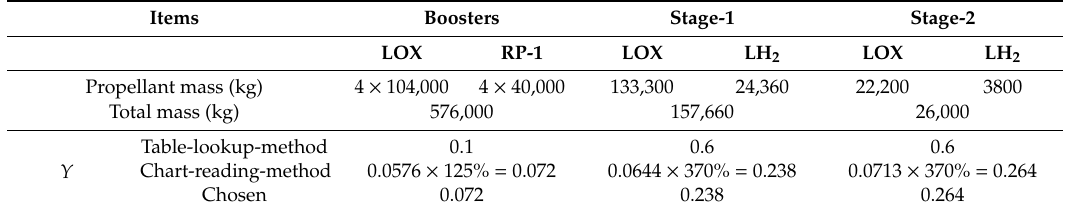
Table 1. Equivalent yields at di ff erent stages of a certain rocket.